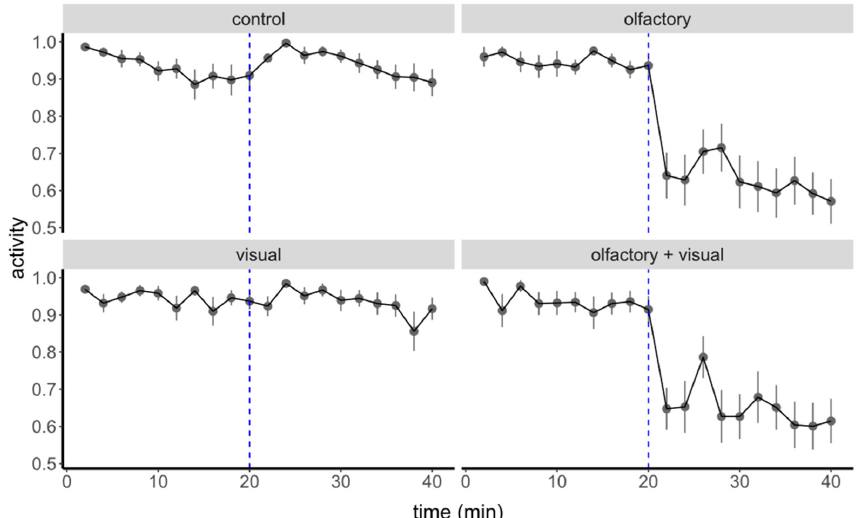
Figure 2. Mean proportion of active tadpoles during the 20 min pre- and post-stimulus. Each point represents a mean obtained from 24 individuals within a 2-min interval (overall, n = 96). Blue dashed lines indicate the moment of cue presentation, at the twentieth minute from the start of the experimental trial.